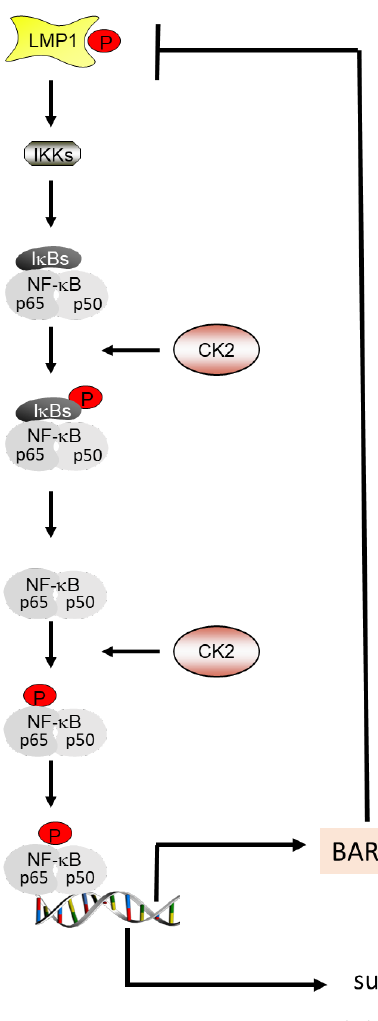
Figure 1. LMP1, BARTs, CK2 and the NF- κ B signaling pathway. LMP1, NF- κ B and BARTs are implicated in an autoregulatory loop. CK2 phosphorylates and thereby stimulates the NF- κ B signaling pathway. As an activated transcriptional regulator, NF- κ B increases the expression of BARTs and the expression of genes implicated in cell survival, proliferation and migration.